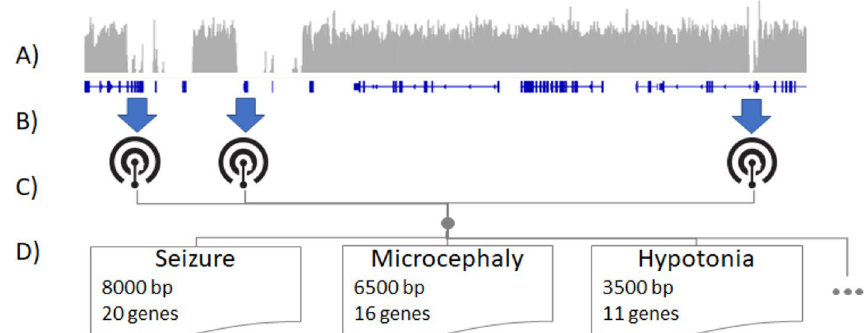
Figure 2. Illustrative schematic of determining HPO terms best assayable by LRS. ( A ) SRS genomic coverage (gray bars) averaged across hundreds of genomes is calculated for each gene (blue lines). ( B ) Disease genes are mapped to HPO terms. ( C ) Terms are assembled and ( D ) the number of genes and the SRS-uncoverable size are assembled for each HPO term. These can then be used to prioritize patients for long read